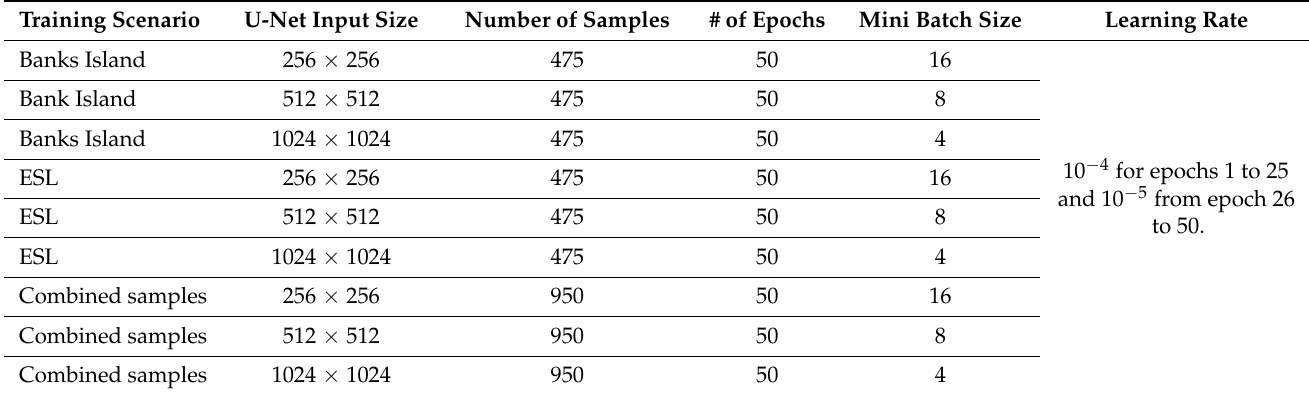
Table 5. Model training parameter